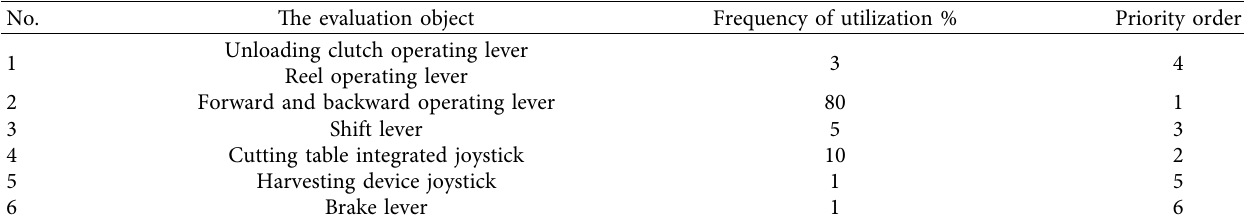
Table 1: Weight value and priority of each component of human-machine interface of combine harvester cab.